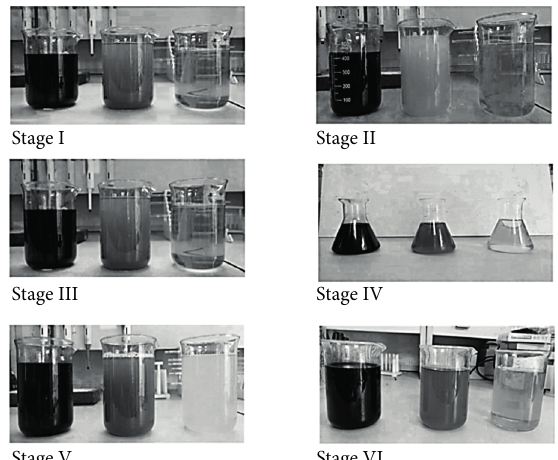
Figure 8: Can accept messages sent by other nodes that are not